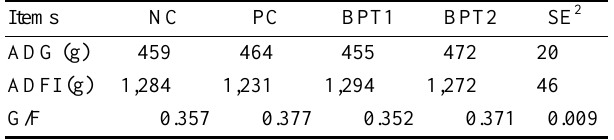
Table 2. Effects of bacterphage on growth performance in growing pigs 1